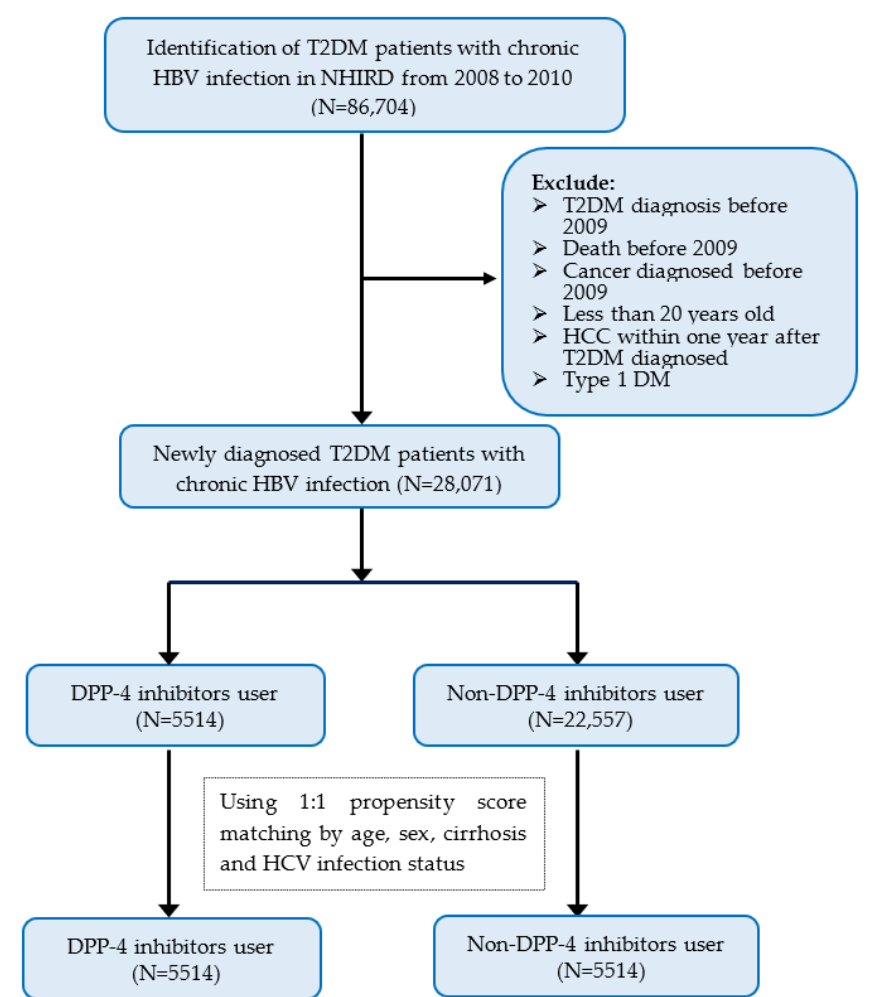
Figure 1. Flow chart of study patient selection. Abbreviations : T2DM, type 2 diabetes mellitus; HBV, hepatitis B virus infection; NHIRD, National Health Insurance Research Database; DPP-4 inhibitors, dipeptidyl peptidase-4 inhibitors.